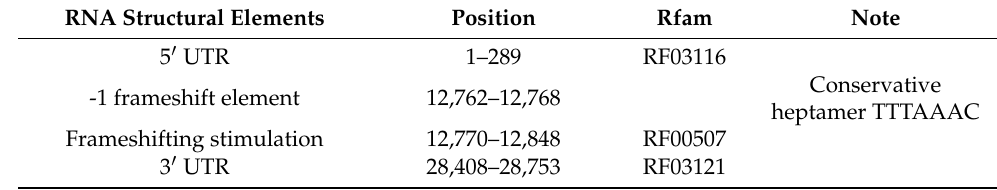
Table 2. Secondary structural genomic elements of novel alphacoronavirus strain HCQD-2020.